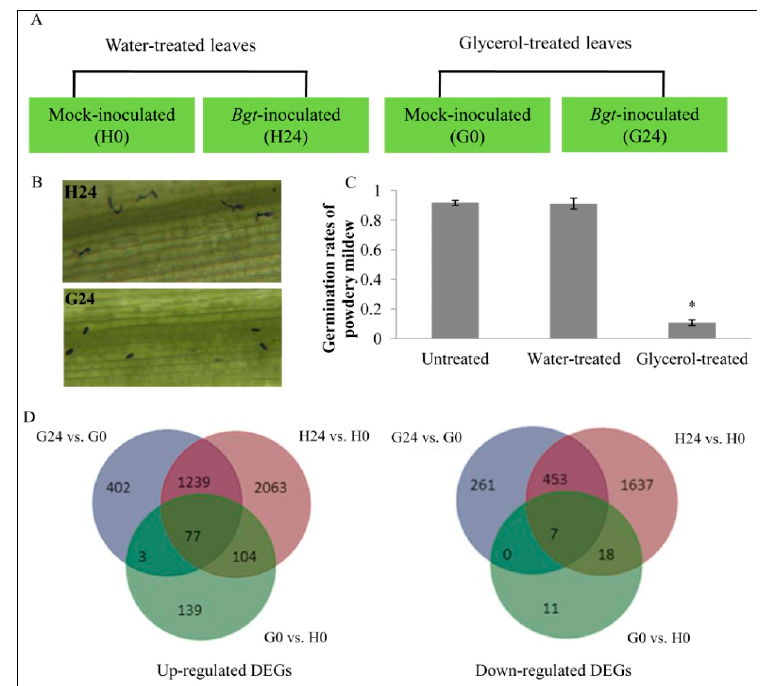
Figure 1. Application of glycerol enhanced Bgt resistance in wheat and transcriptome analysis. ( A ) Experimental design. ( B ) Morphology of conidiospore and hyphae in untreated, water-treated, and glycerol-treated Xuezao leaves at 24 h post powdery mildew infection (hpi). ( C ) Germination rates of powdery mildew on the water-treated and glycerol-treated wheat leaves at 24 hpi. Each value is the mean ± standard error (SE) of three independent biological repetitions. Asterisk indicates a significant difference from the germination rates of treated leaves at p ≤ 0.05 by Student’s t -test. ( D ) Differentially expressed genes (DEGs) overlapped in different groups comparison. H0 and G0 groups presented water or glycerol-treated plants without Bgt infection; H24 and G24 group presented water or glycerol-treated plants with Bgt infection.